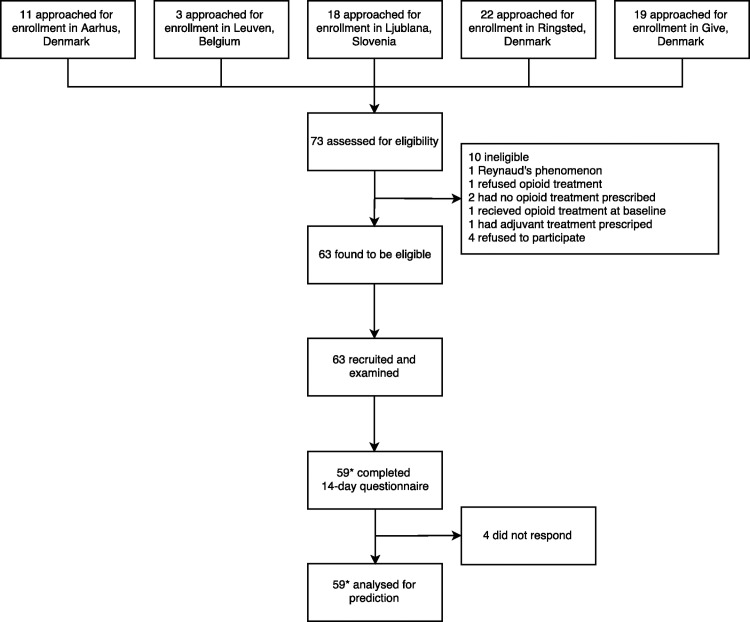
Flowchart.Numbers of patients screened for eligibility, examined, and analyzed for primary outcome.